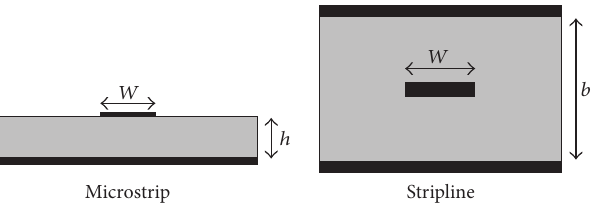
Figure 3: Microstrip and Stripline.